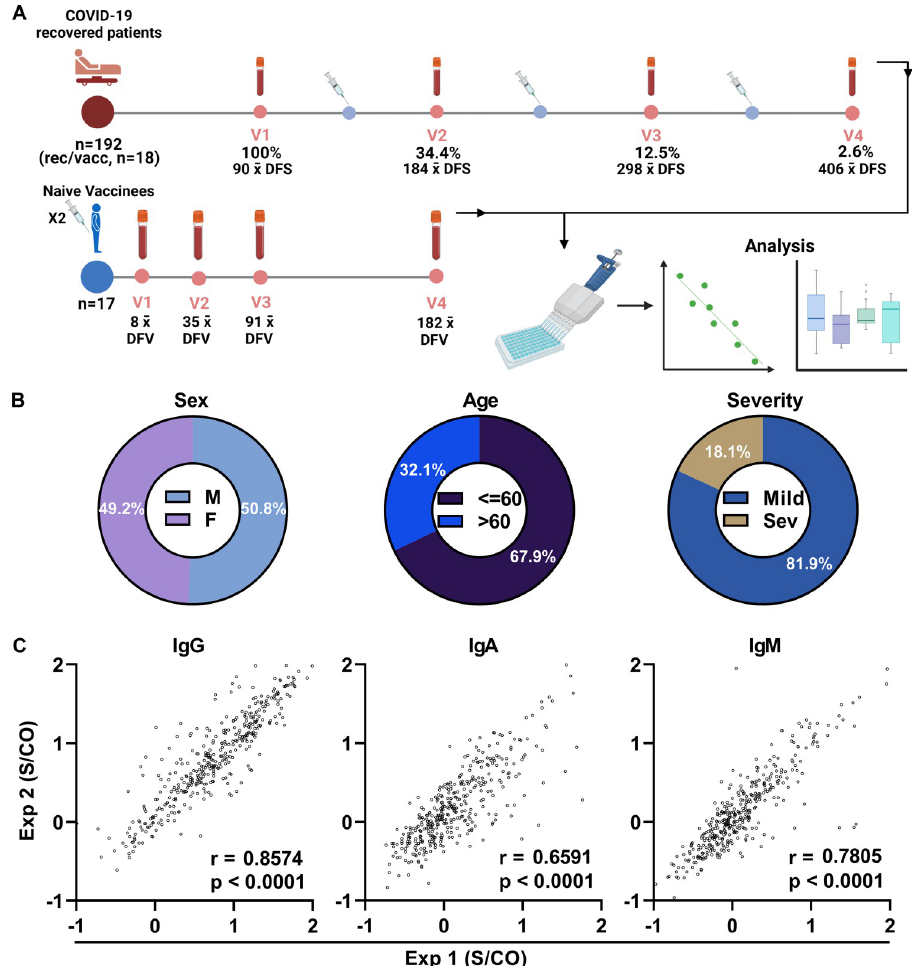
Fig 1. Experimental design, cohort characteristics, and reproducibility of antibody level measurements. (A) The cohort comprised 192 COVID-19 recovered patients; blood samples were obtained from all the patients at V1, and from 66 patients at subsequent visits (V2-V4) at intervals of approximately 3 months between visits. A subset of the patients (n = 18) received one dose of an mRNA-vaccine at various time points [days following the onset of symptoms (DFS)], indicated by syringe icons at various time points. Blood samples were also collected from a cohort of na ï ve vaccinees (n = 17) who received 1 and 2 doses the mRNA-vaccine. All blood samples were fractionated for the isolation of plasma samples, which were used for the determination of the RBD + antibody levels and for the analysis of the longitudinal kinetics. (B) The characteristics of the cohort of COVID-19 recovered patients included a balanced male/ female population, with 67.9% below and 32.1% above 60 years. The majority of patients exhibited mild symptoms (81.9%), but symptoms were severe in 18.1% of patients. (C) RBD + measurements were carried out in duplicate, and each experiment was repeated twice (designated Exp1 and Exp2 on the x- and y-axes, respectively). Values on the x and y axes are presented as log 10 signal over cutoff (S/CO). Pearson’s correlation coefficient (r) was used to determine the reproducibility of the experiments. p values < 0.05 were considered